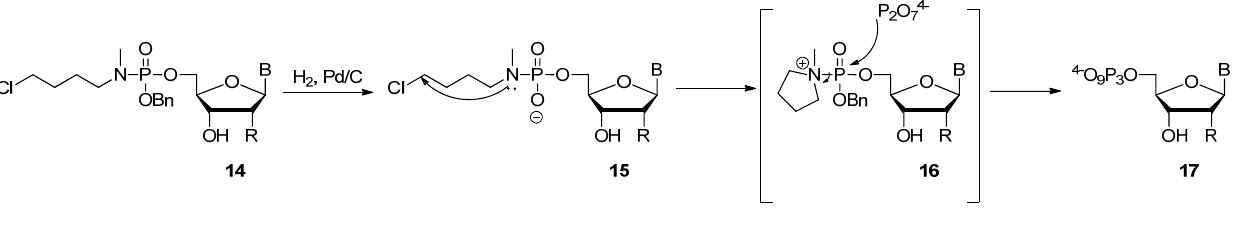
Scheme 3. The Borch approach for the synthesis of nucleoside triphosphates (B = modified or natural nucleobase; R = H, OH, or